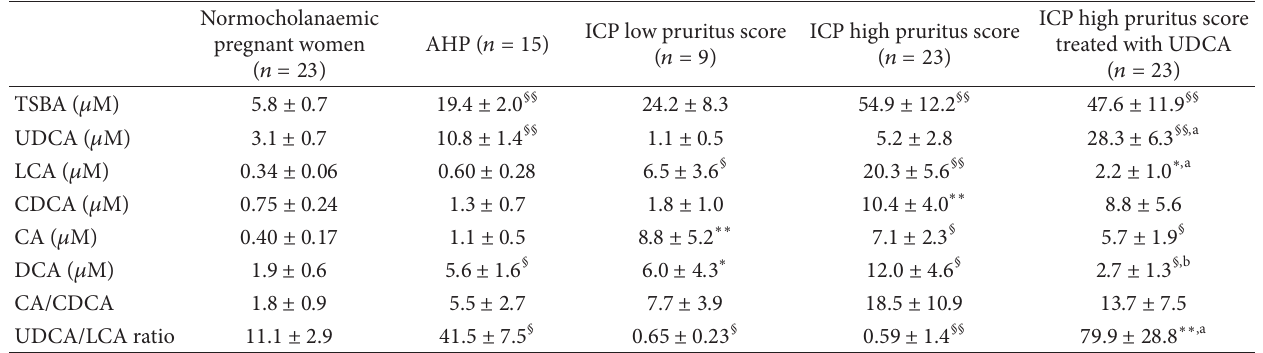
T 2: Comparison of TSBA levels and serum bile acid pro�les in all of the groups studied.